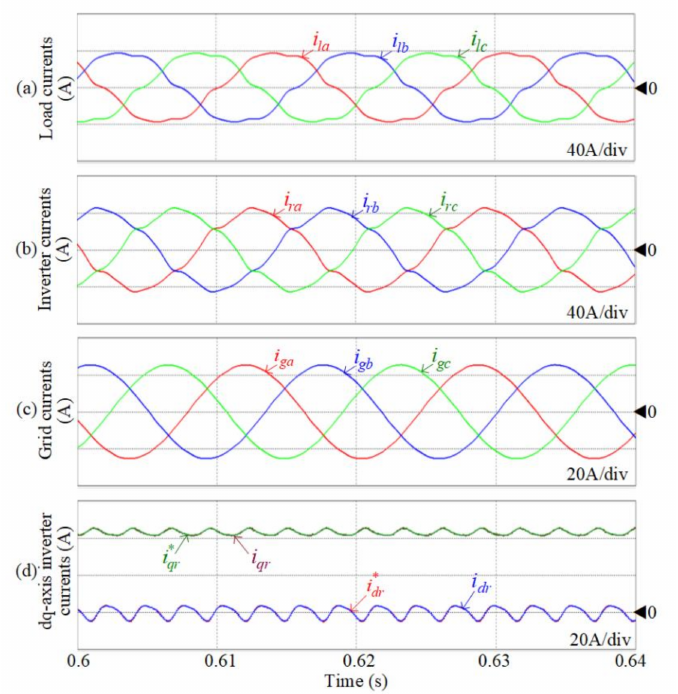
Figure 4. Control performance of the microgrid under the grid-connected modes: ( a ) load currents;